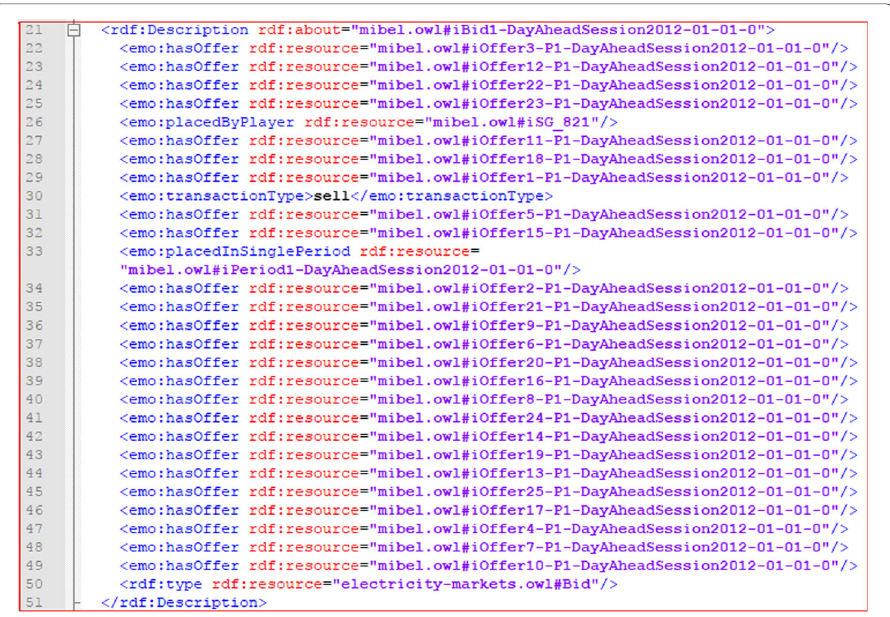
Fig. 5 Snippet of spot proposal presented by SG